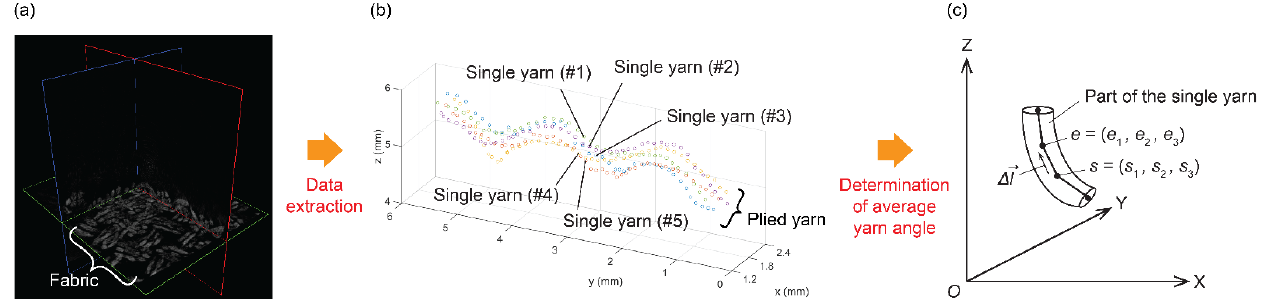
Figure 8. 3D visualization of the cotton fabric geometry for determination of the average yarn orientation: ( a ) micro-computed tomography (micro-CT) image, ( b ) five-ply cotton yarn plotted in the Cartesian coordinate system, and ( c ) yarn discretization for calculation of the local orientation. Adapted from [7] (pp. 10–11). Copyright 2019 YUSUKE MUKAI.